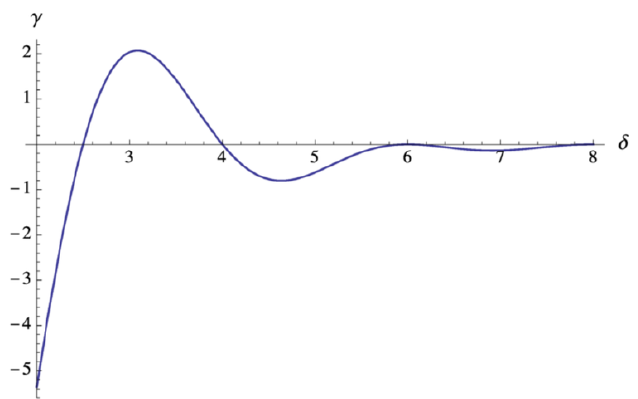
Figure 1 . Contribution to the anomalous dimension (cid:13) 0 ; 0 from the symmetric exchange of a scalar primary, in units of a (cid:14)